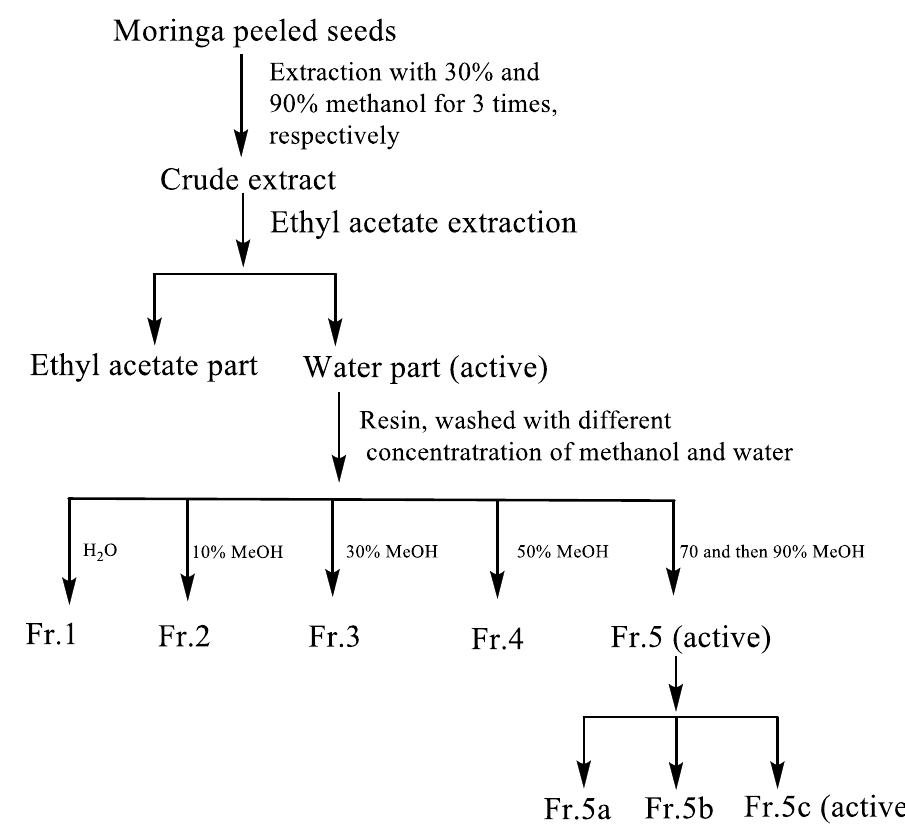
Figure 1. Bioactivity-guided isolation of the anti-adipogenic compounds from Moringa seeds.